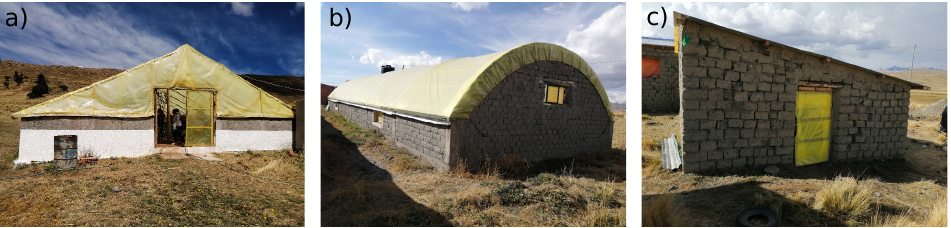
Figure 2. Photographs illustrating the different greenhouse roof types used by local farmers: ( a ) two slopes, ( b ) semi spherical, ( c ) single slope. These images correspond to greenhouses 1, 22, and 25, respectively (see their characteristics in Table 1). Table 1. Position, greenhouse ground surface, catchment surface, closest rain gauge, and distance, as well as volume of water used for irrigation for the two types of irrigation